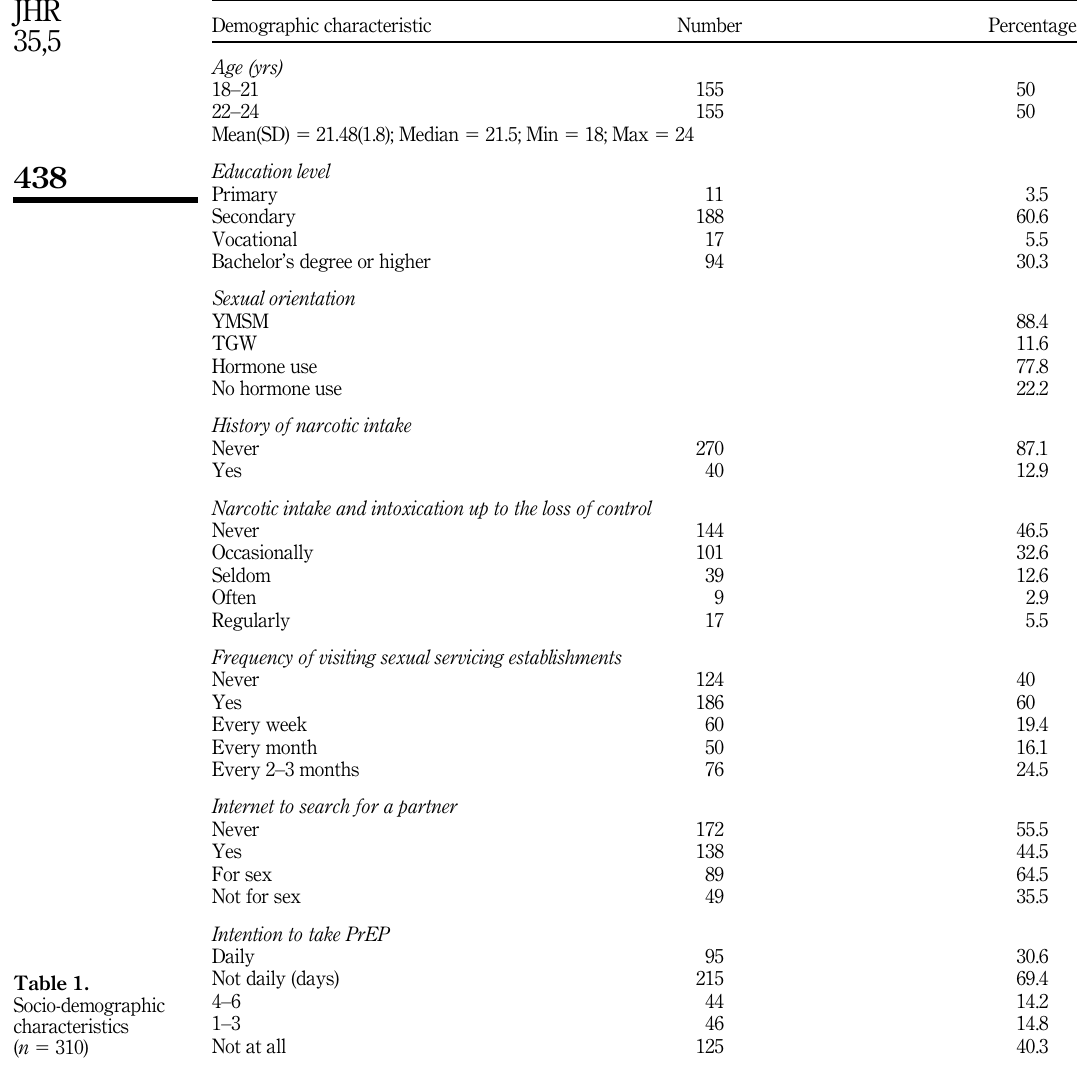
characteristics ( n 5